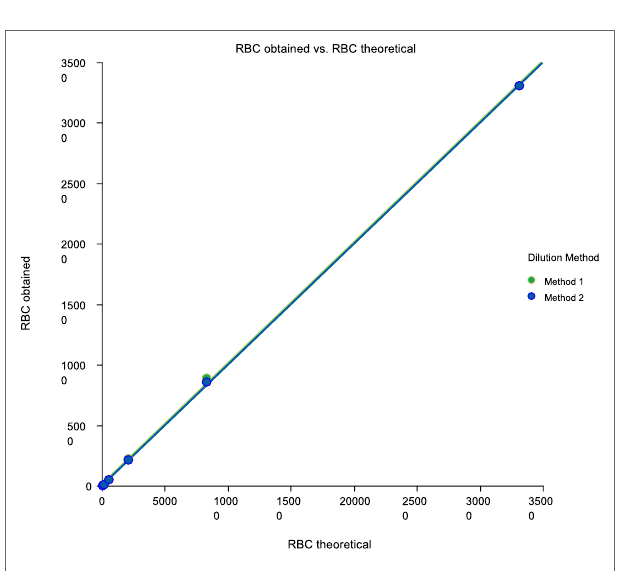
FIgURe 6 | Scatter diagram of obtained and theoretical RBC in sample 3.